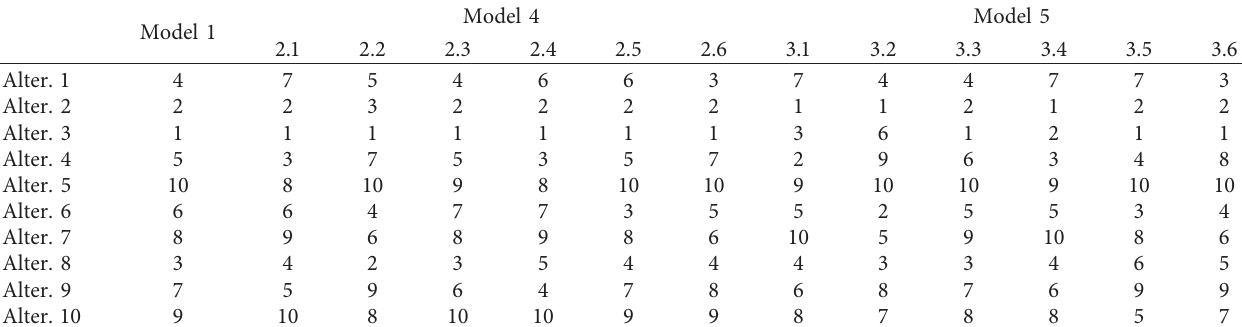
Table 16: Comparison of the ranks of alternatives according to models 1, 4, and